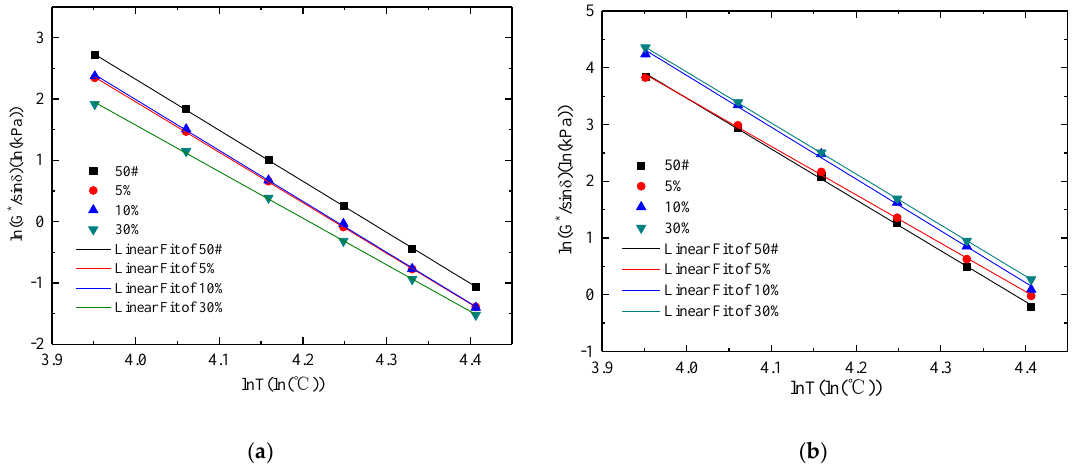
Figure 10. Linear regression between ln (G*/sinδ) and lnT. ( a ) Unaged; ( b ) RTFO-aged. Table 2. Linear fitting results of different asphalt temperature sweep data for the unaged asphalts. Asphalt Type